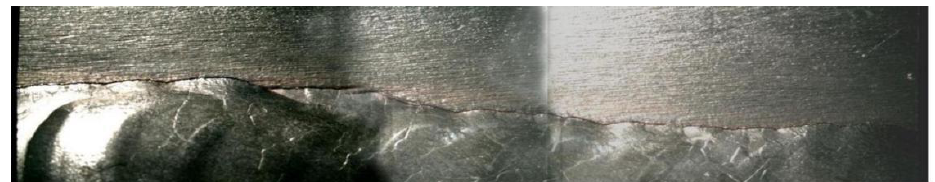
Figure 11. The macroscopic photograph of the crack along the upper edge.